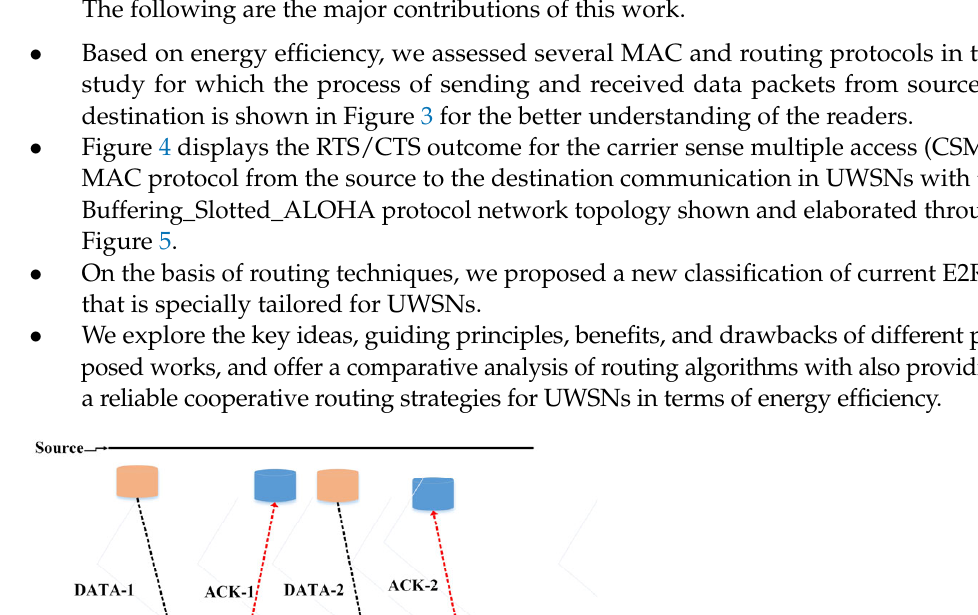
Figure 4. Result of RTS/CTS with CSMA [43]. Figure 5. Buffring_Slotted_ALOHA protocol topology [44].